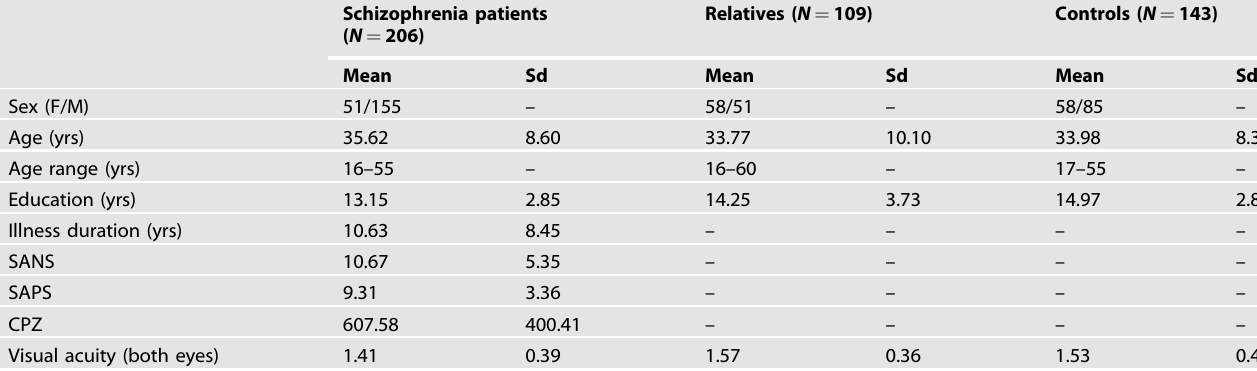
Table 1. Participants ’ characteristics.